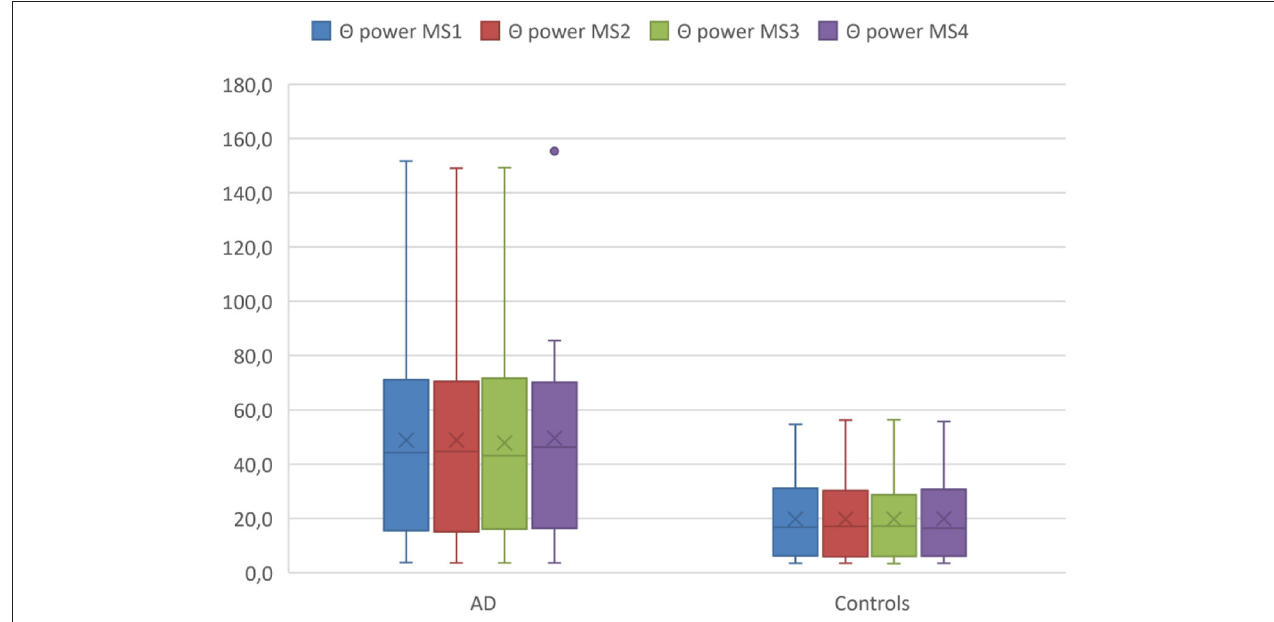
FIGURE 2 | Theta ( 2 ) power within MS classes between diagnostic groups. Boxplot Theta ( 2 ) power of microstates averaged across the entire acquisition period comparing the AD group with the controls. Boxplots show 1st quartile, median, and 3rd quartile as well as mean values (large cross).